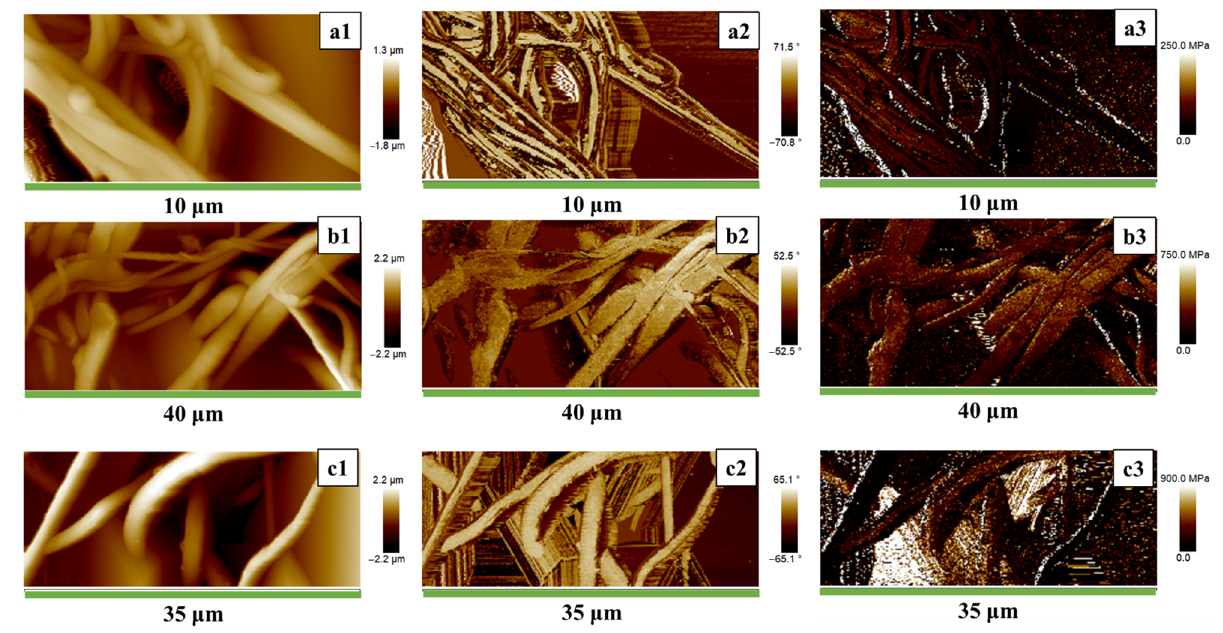
Figure 4. H-AFM images of PCL membranes loaded 0% ( a ), 5% ( b ) and 10% ( c ) of F-Fe 3 O 4 nanopar- ticles. The images in the first column ( a1 , b1 , c1 ) show the Height profile; the images in the second column ( a2 , b2 , c2 ) show the Phase ( a2 , b2 , c2 ); the images in the third column ( a3 , b3 , c3 ) show the DMT Modulus.